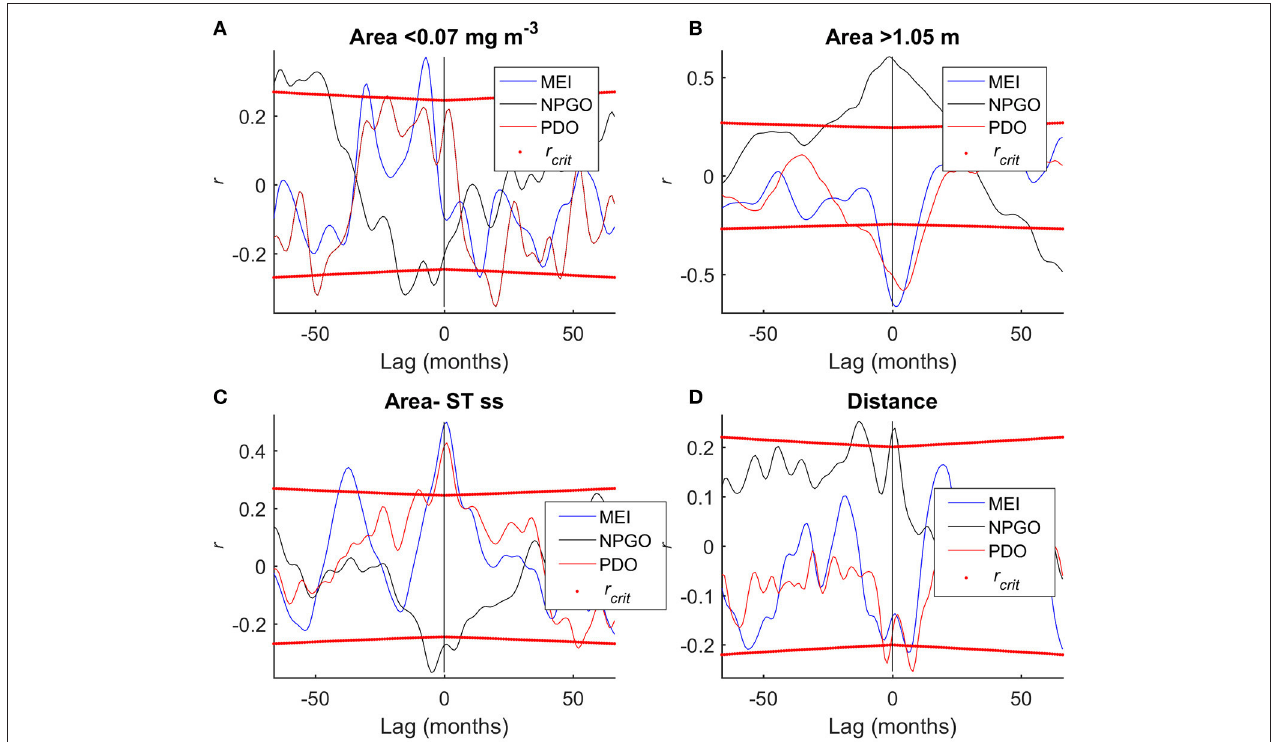
FIGURE 4 | Lagged correlations between climate indices and dynamic geography indices of the North Pacific Subtropical Gyre. Where lag is negative, climate index leads geographic metric; the converse is true for positive lags. Correlations are significant when they exceed the critical value (dotted red lines). (A) Gyre area defined by chl a ≤ 0.07mg m − 3 . (B) Gyre area defined by closing contour of dynamic height (1.05m). (C) Gyre area defined by the extent of the multivariate subtropical seascape. (D) Distance from Station ALOHA to the edge of the subtropical seascape.